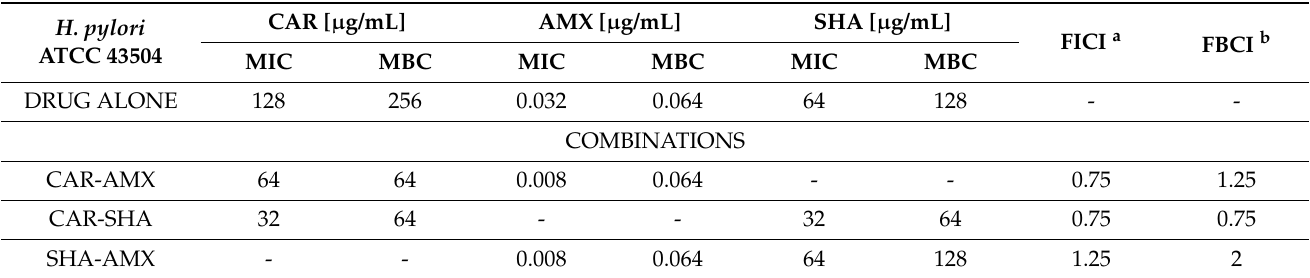
Table 1. MIC and MBC values for CAR, AMX and SHA, alone and in combination, and their corresponding FICI and Fractional Bactericidal Concentrations Index (FBCI) against H. pylori ATCC 43504 through the checkerboard